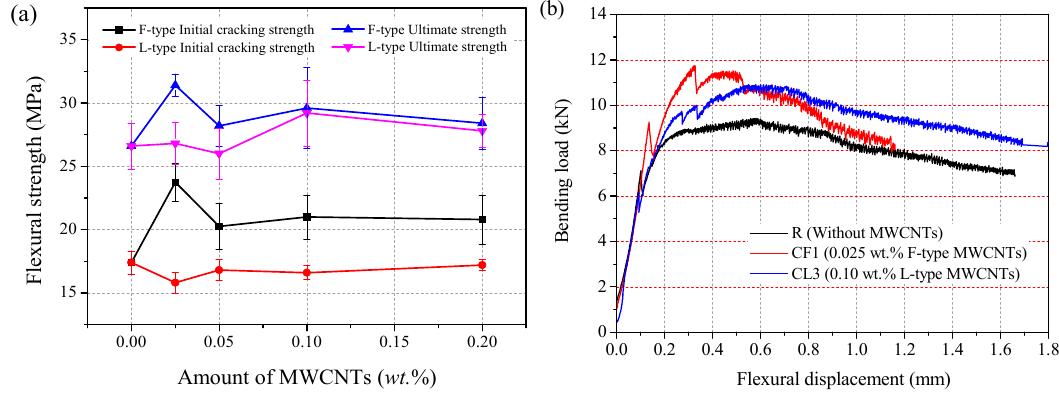
Figure 4. Flexural test results of each group ( a ) and typical load-displacement curve ( b ).